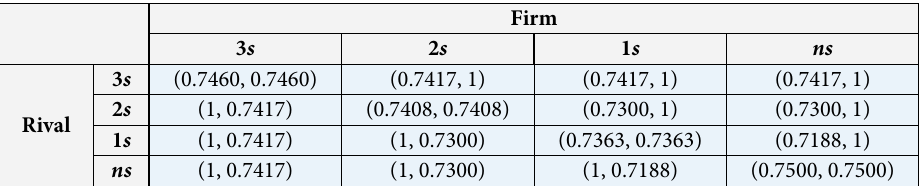
Table 12. Technological transition: two observations, risk-neutral DM, and signals on X 1 : expected value reference setting